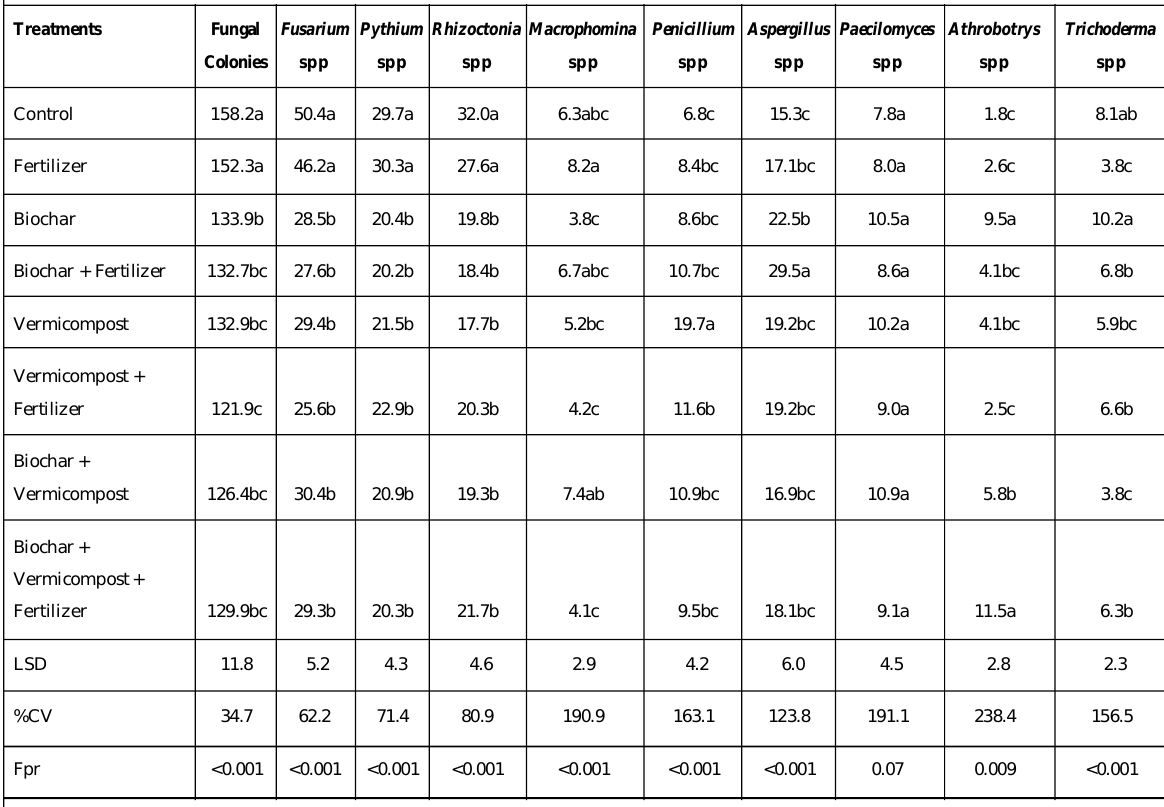
Table 12: Effect of biochar and vermicompost on fungal populations ( × 10 3 CFU/g soil) six weeks after planting common bean in the long rains season of 2014 Treatments